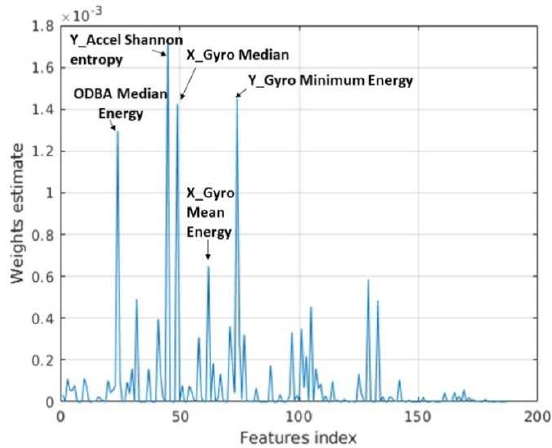
Figure 7. Estimation of feature importance for the random forest (RF) with the five most important features indicated. Note X_Gyro Median is the only time-series feature, while the rest are frequency domain features.